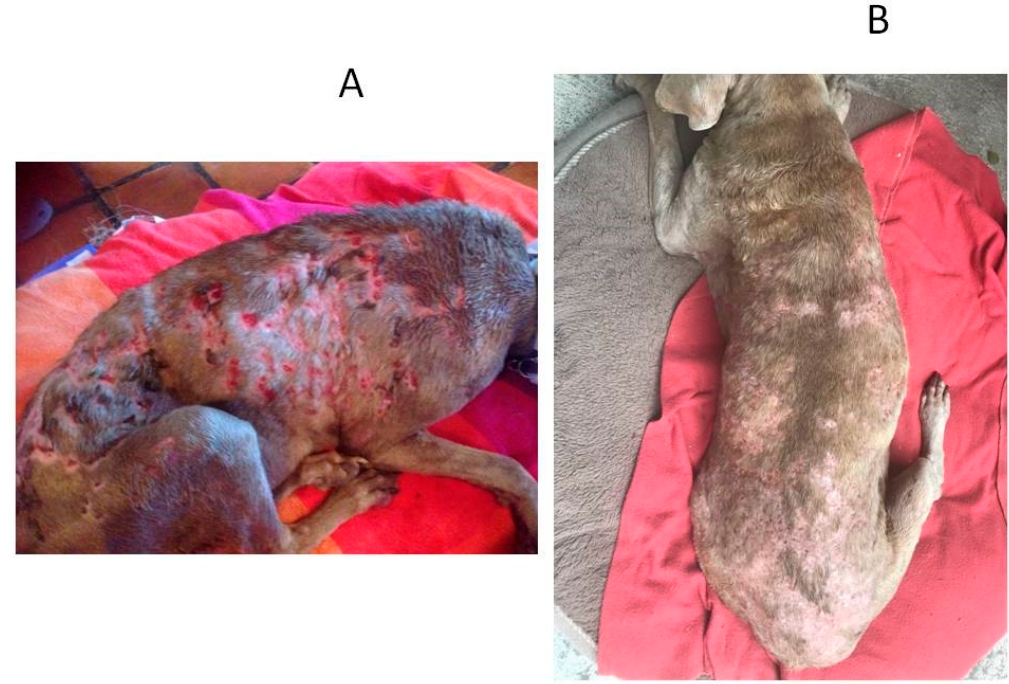
Figure 1. Canine unresponsive deep-pyoderma, classified as very severe, and treated with enrofloxacin HCl-2H 2 O (enro-C) at a dose of 10 mg/kg orally in gelatin capsules, plus the topical administration thrice a day of enro-C prepared as gel. Aspect of the disease in a dog at admission ( A ) and 10 days later ( B ).